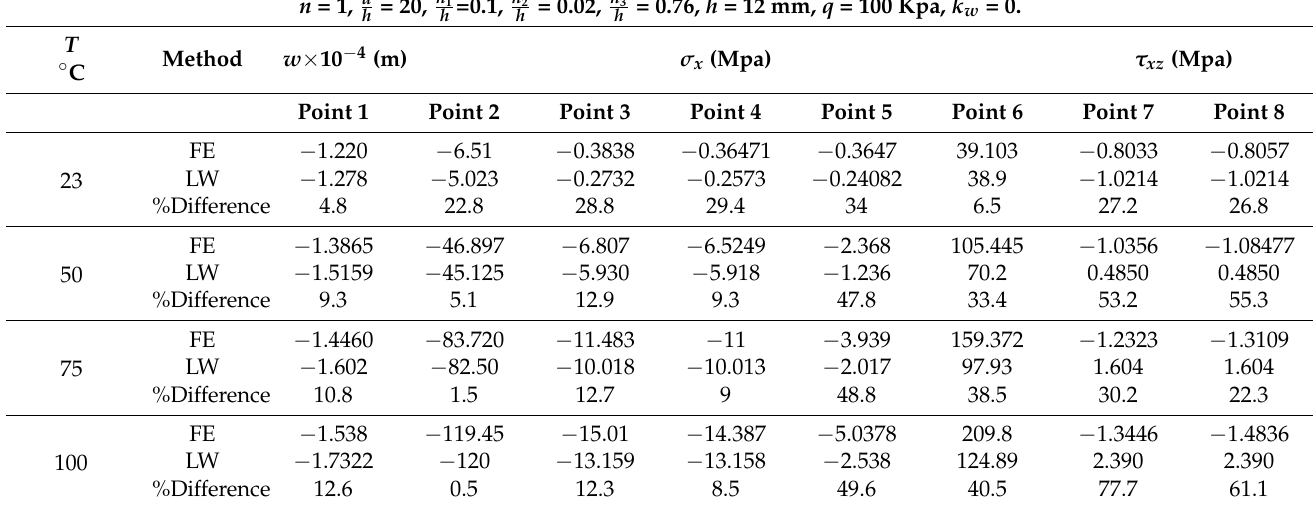
Table 6. Comparison of the results based on LT and those of FE findings for different temperature.